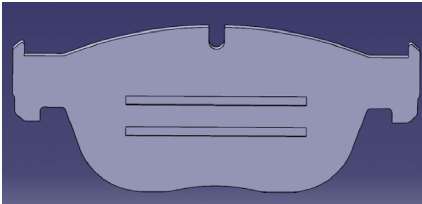
Figure 7: Sample 2 (double horizontal